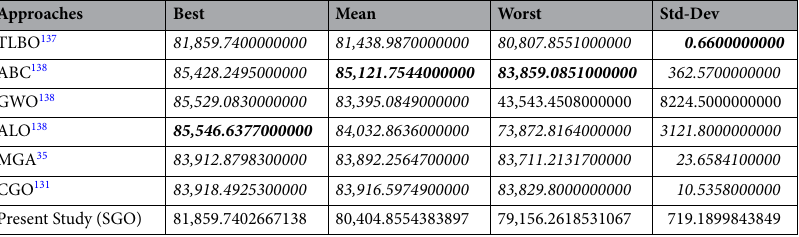
Table 15. Statistical results of different approaches for the rolling element bearing design problem. Significant values are in bold and italics.